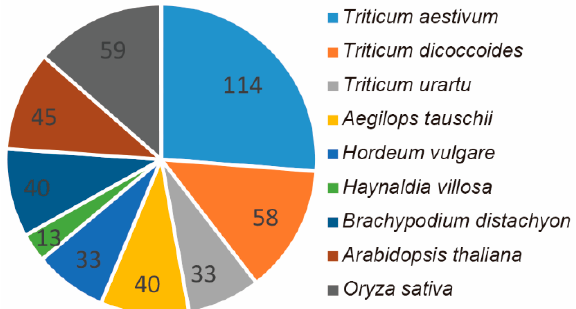
Figure 1. The total number of heavy-metal-associated isoprenylated plant protein ( HIPP ) genes in the nine species of T. aestivum , T. dicoccoides , T. urartu , Ae. tauschii , H. vulgare , H. villosa , B. distachyon , A. thaliana, and Oryza sativa .